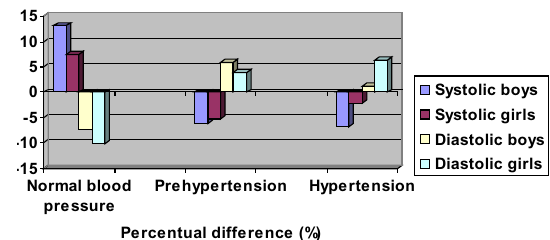
Figure 1 Evaluation of blood pressure in children age between 10 and 15 years